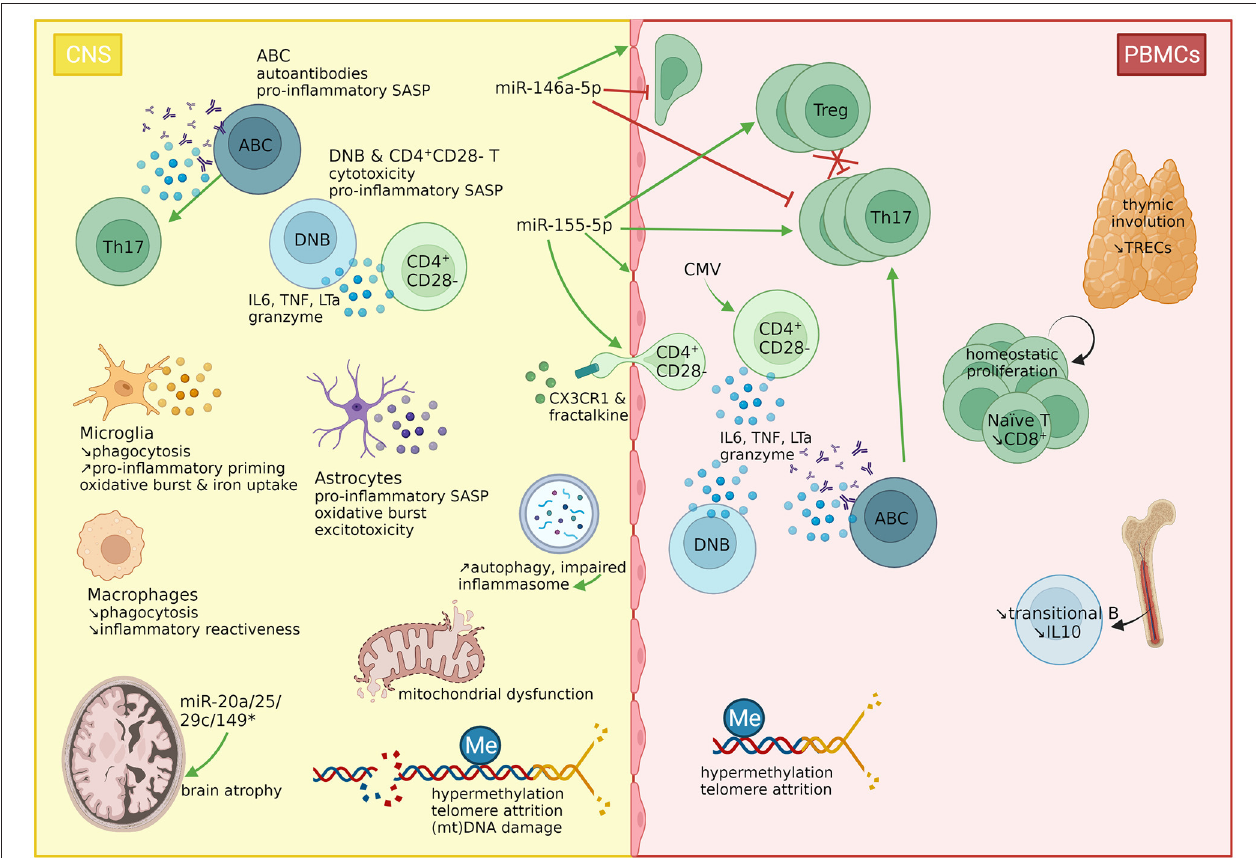
FIGURE 2 | immunosenescence features in multiple sclerosis. Features of immunosenescence have been described in MS. The thymic involution (measurable by reduced TREC levels) induces the homeostatic proliferation of T cells. However, naïve T cells rapidly differentiate into memory T cells due to antigenic stimulation. While Th17 cells, and to a lesser extent, Tregs are expanded in the periphery, the latter fail to suppress Th17 cells. A subset of CD4 + T cells has lost the costimulatory signal CD28, marking the T cell exhaustion mainly through sustained CMV stimulation. These cells express the CX3CR1 receptor, favoring their migration through the BBB, as their ligand, fractalkine, has been found overexpressed in the cerebrospinal fluid (CSF). The B cell compartment is characterized by a reduction in immunoregulatory transitional B cells, but an increase in double negative B cells (DNBs) and ABCs. These three subsets (CD4 + CD28 − T cells, DNBs, ABCs) have been linked to immunosenescence and detected in the CNS of MS patients. CD4 + CD28 − T cells and double negative B cells produce TNFa, and granzyme B. CD4 + CD28 − T cells produce also IL6, and double negative B cells produce LTa, hence corresponding to the senescence-associated secretory phenotype of these cells. ABCs produce TNFa and autoantibodies and polarize Th17 cells. In the CNS, both microglia and macrophages have impaired phagocytic properties, but while microglia are primed, macrophages lose their inflammatory reactiveness. Microglia further produce ROS and incorporate iron. Astrocytes produce also proinflammatory cytokines and ROS and release glutamate, inducing excitotoxicity. The oxidative burst causes mitochondrial dysfunction, and (mitochondrial) DNA damage. Autophagy is increased but impaired, which might induce the inflammasome. Moreover, telomeres shorten with age and disease progression. Interestingly, hypermethylation is a common feature in PBMCs from MS patients, found in several subsets as well as in brain tissues, while hypomethylation has on the contrary been linked to aging. Finally, miR-146a-5p and miR-155-5p are two major immuno-microRNAs with opposite effects on the integrity of the BBB, T cell migration and the differentiation of Th17 cells. Herein, miR-155-5p displays pro-inflammatory characteristics, but also supports the differentiation of Tregs. Four miRNAs (miR-20a/25/29c/149*) have been linked to brain atrophy. CMV, cytomegalovirus; CNS, central nervous system; CX3CR1, C-X3-C Motif Chemokine Receptor 1; B, B cell; ABC, age-associated B cell; DNB, double negative B cell; IL, interleukin; LTa, lymphotoxin A; Me, methylation; mt, mitochondrial; MS, multiple sclerosis; PBMCs, peripheral blood mononuclear cells; SASP, senescence-associated secretory phenotype; T, T cell; Th, T helper cell; TRECs, T cell receptor excision circles; Treg, regulatory T cell; TNF, tumor necrosis factor. Created with